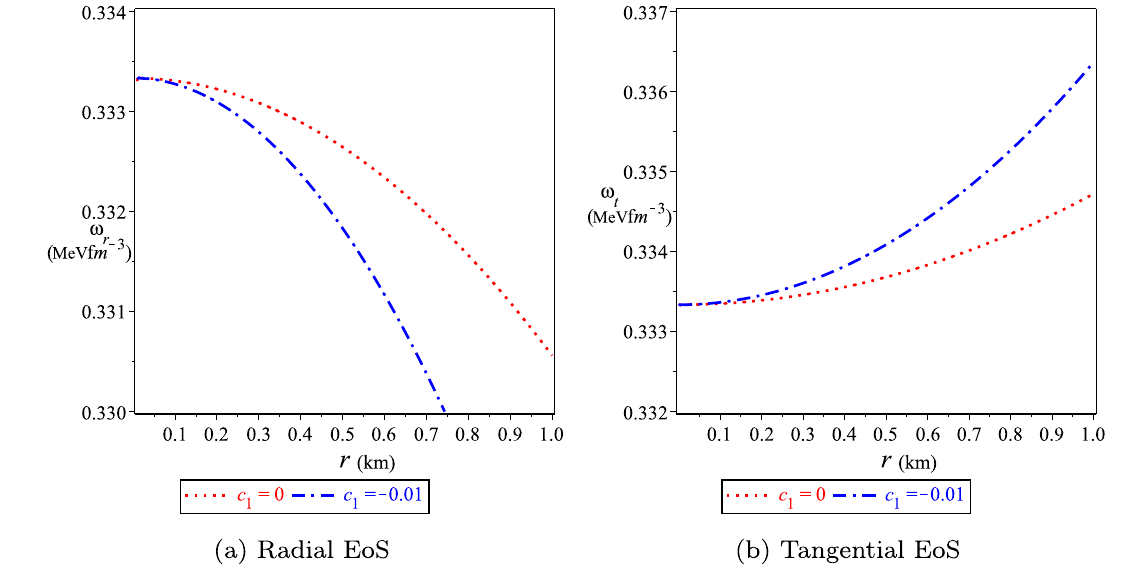
Fig. 10 Plots of the radial and transverse EoS of solution